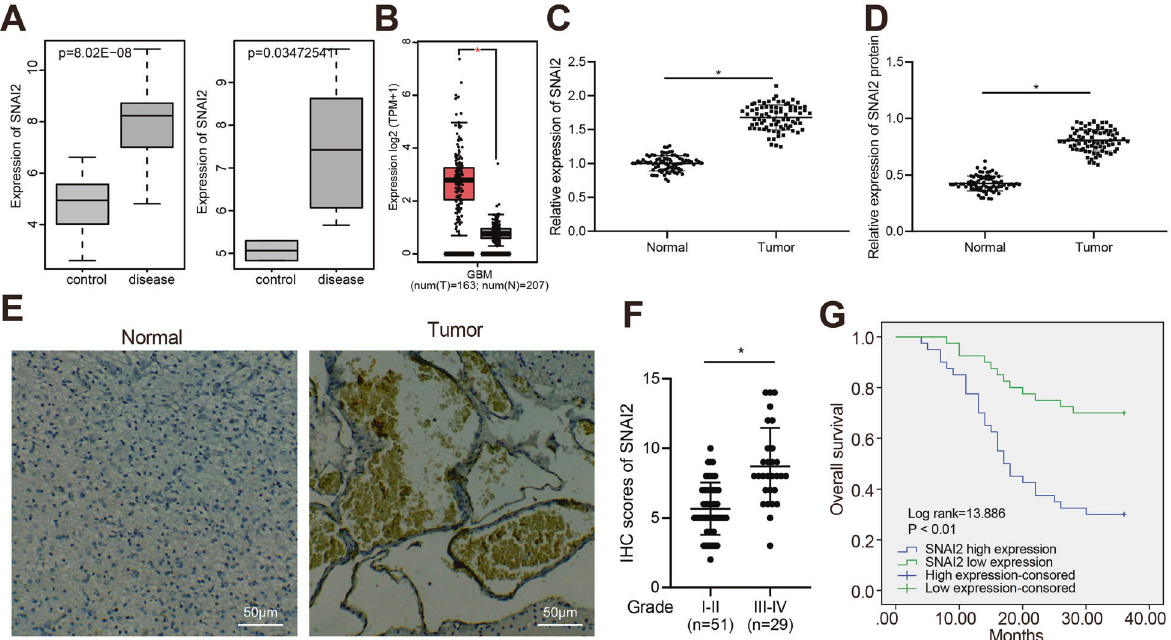
Fig. 1 SNAI2 expression is upregulated in glioma tissues. A The high expression of SNAI2 in glioma as predicted on the GSE50161 (left panel) and GSE15824 dataset (right panel). In the fi gure, the x -axis indicates the sample type, the y -axis indicates the gene expression value, and the upper left indicates the differential p value. B The expression of SNAI2 gene in TCGA glioma dataset. The x -axis indicates the sample type, the y -axis indicates the expression value, the red box plot indicates the tumor sample, and the gray indicates normal sample. * p < 0.05 vs. normal tissues. C SNAI2 mRNA expression in glioma tissues and adjacent normal tissues as determined by RT-qPCR. n = 80. * p < 0.05 vs. adjacent normal tissues. D SNAI2 protein expression in glioma tissues and adjacent normal tissues as determined by Western blot assay, n = 80. * p < 0.05 vs. adjacent normal tissues. E SNAI2 expression in glioma tissues and adjacent normal tissues as determined by immunohistochemistry. F Immunohistochemistry score of SNAI2 in glioma tissues and adjacent normal tissues. n = 80. G Kaplan – Meier analysis for the correlation between SNAI2 expression and OS of patients with